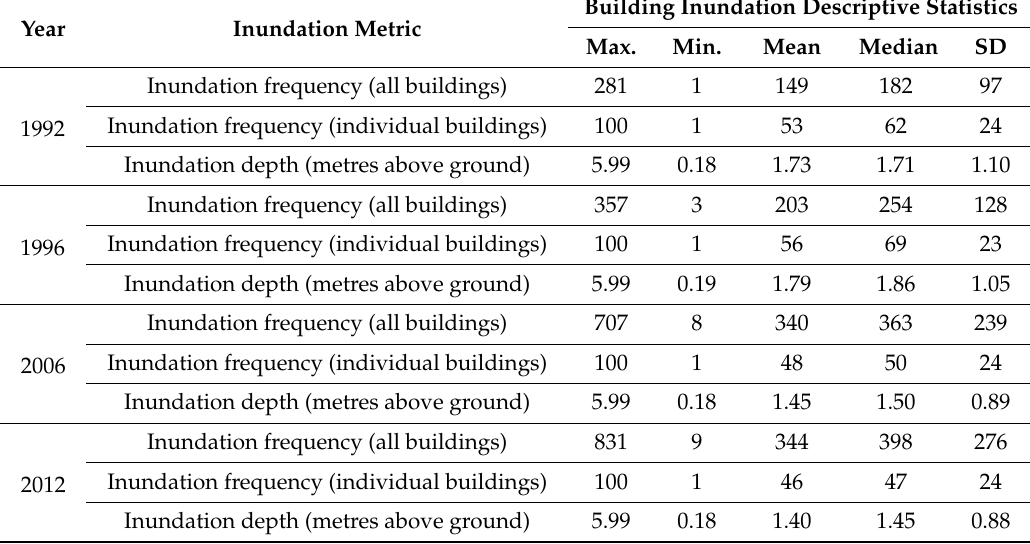
Table 3. Summary of building inundation for all 100 modelled tsunami inundation